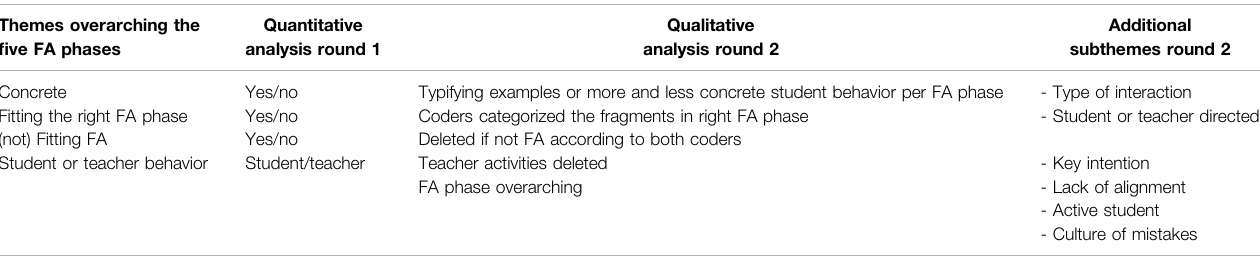
TABLE 1 | Overview of analysis steps, codes and themes.